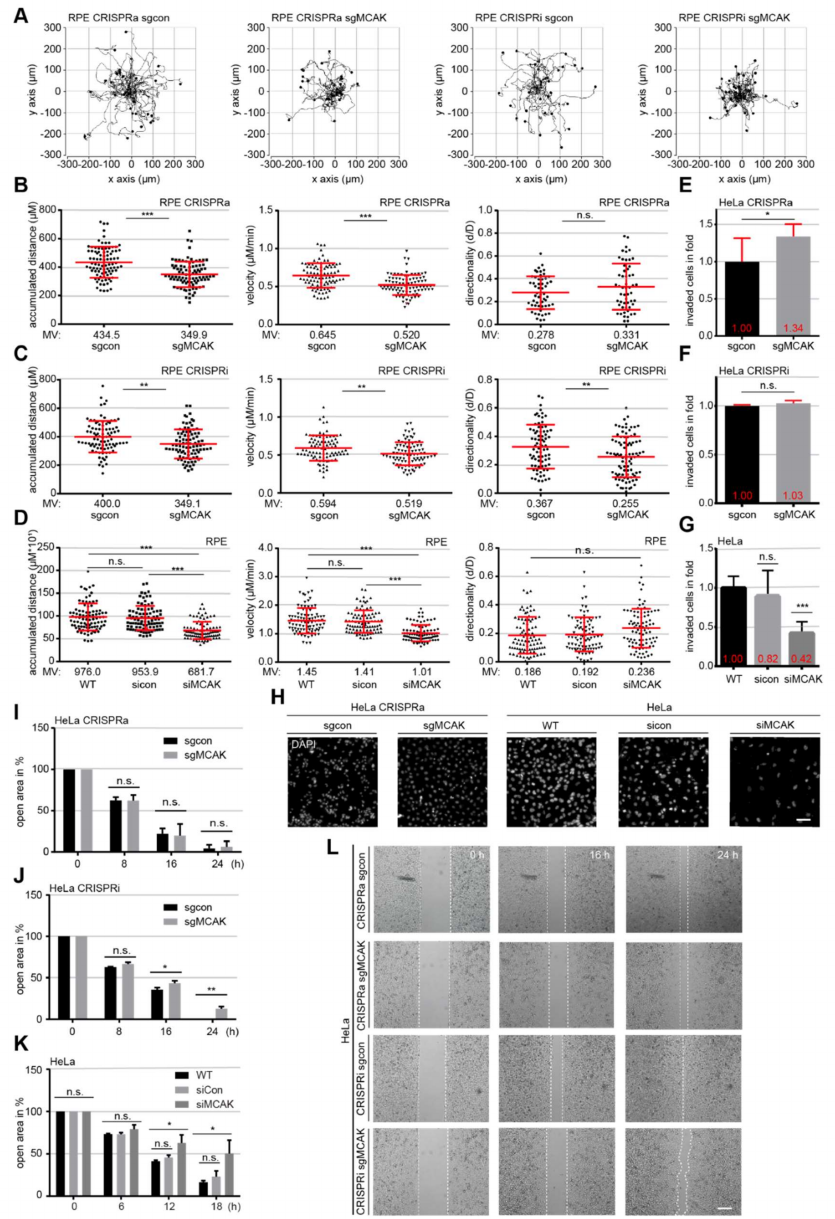
Figure 2. Down-regulated or up-regulated MCAK leads to reduced motility and migration rates. ( A – D ) Time-lapse microscopy was performed with RPE CRISPRi/a cells and RPE cells transiently depleted of MCAK (RPE siRNA). Random motility of these cells was analyzed. Representative trajectories of individual cells ( n = 30) are shown ( A ). RPE CRISPRa ( B ), RPE CRISPRi ( C ), and RPE siRNA cells ( D ) were evaluated for accumulated distance (1st), velocity (2nd), and directionality (3rd), and the results are from three independent experiments, shown as scatter plots with variations. ( E – H ) Invasion assays. The total numbers of invasive HeLa sgcon cells for CRISPRi ( E ) and for CRISPRa ( F ) or HeLa cells ( G ) were assigned as 100%. The results are from three independent experiments and presented as mean ± SEM. ( H ) Representatives of invaded HeLa CRISPRa or HeLa siRNA cells are shown. Scale: 25 µ m. ( I – L ) Wound healing/migration assays were performed with HeLa CRISPRi/a ( I , J ) or HeLa siRNA cells ( K ), and images were taken at indicated time points to document the migration front. ( I – K ) Quantification of the open area between both migration fronts at various time points. The cell-free area at 0 h was assigned as 100%. The results are from three independent experiments and presented as mean ± SEM. ( L ) Representatives are shown. White dashed line depicts the migration front. Scale: 300 µ m. Unpaired Mann–Whitney U test was used in ( B–D ). ** p < 0.01, *** p < 0.001. Student’s t -test was used in ( E–G ) and ( I , J , K ). * p < 0.05, ** p < 0.01, *** p < 0.001. Abbreviation: n.s.: not